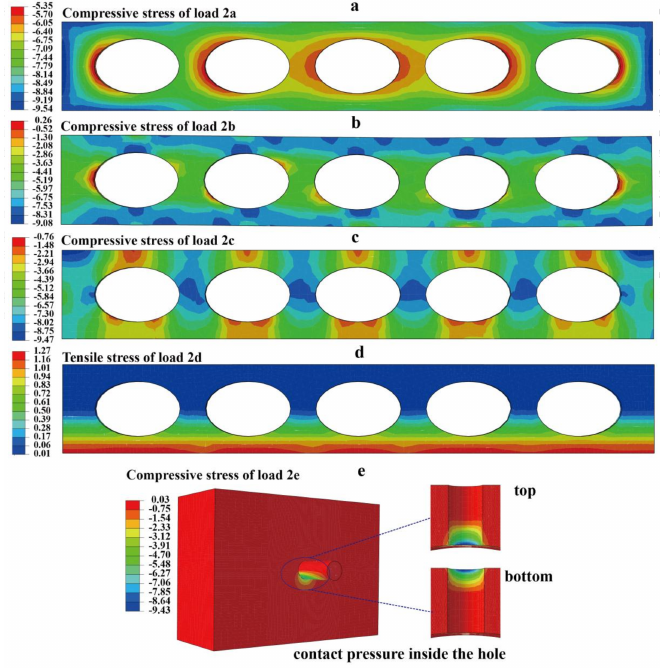
Figure 7. Stress distribution at the failure simulation (in MPa): ( a – e ) stress contours under failure simulation for the five loading conditions, according to Figure